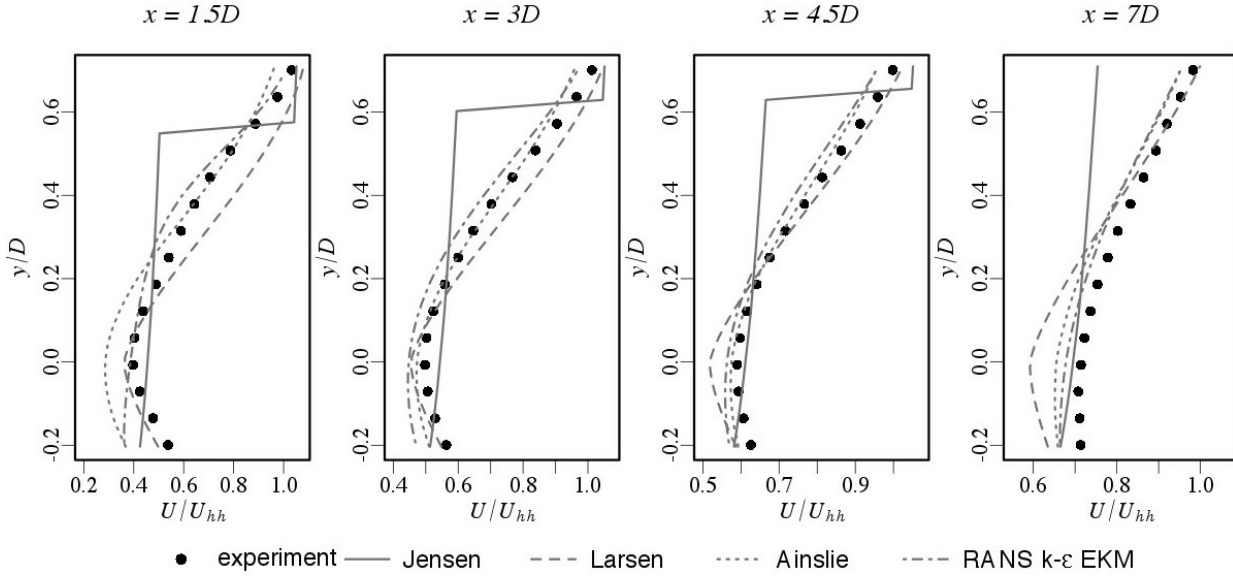
Figure 19. Comparison of measured mean profiles of U/U the fixed case.